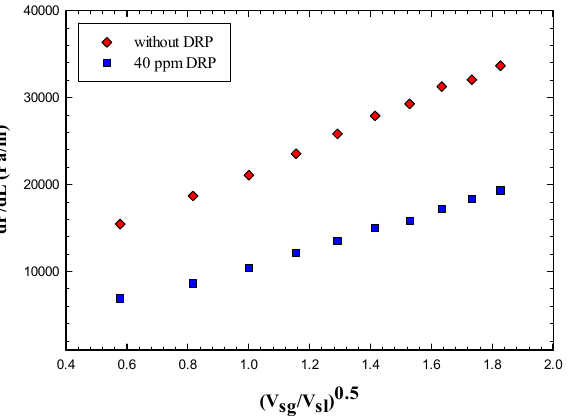
Figure 10. Effect of drag reducing polymer on dispersed bubbly flow regime.